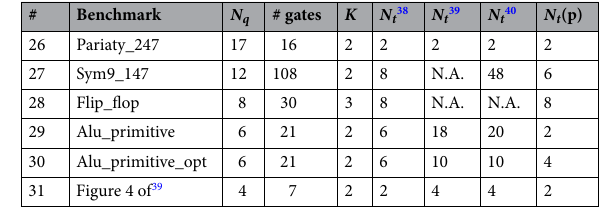
Table 5. The teleportation cost of the proposed method ( N t ) on Circuits 26 to 31 in comparison with of 38–40